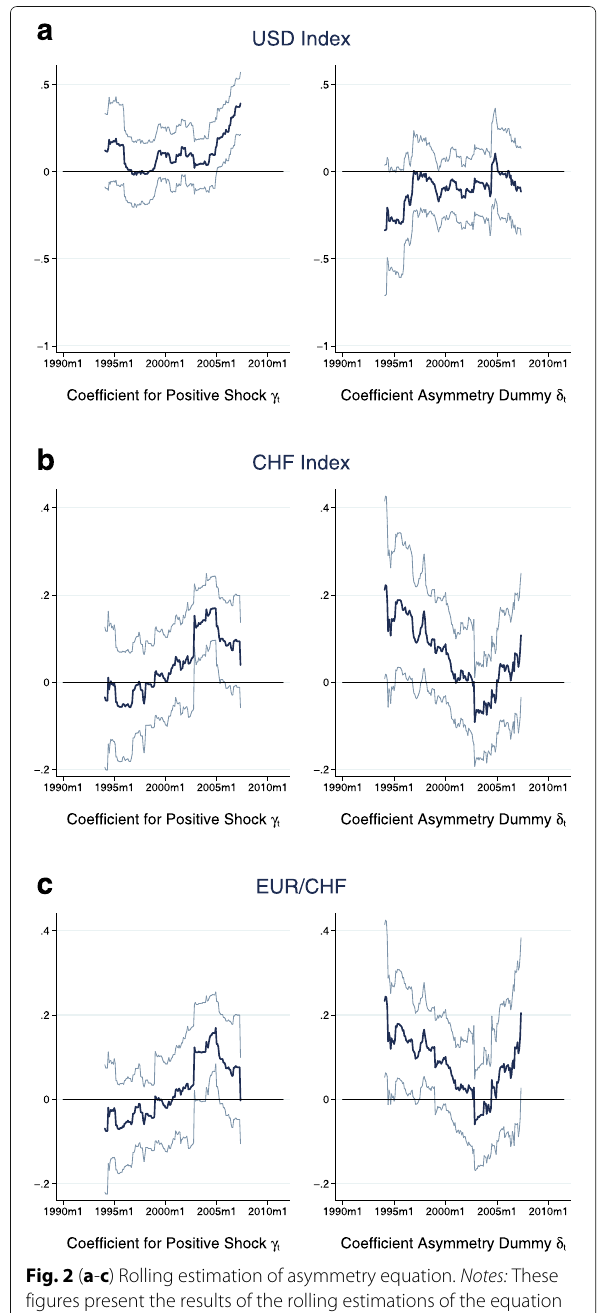
and the euro in particular given the positive correlation of the exchange rate returns with the stock market